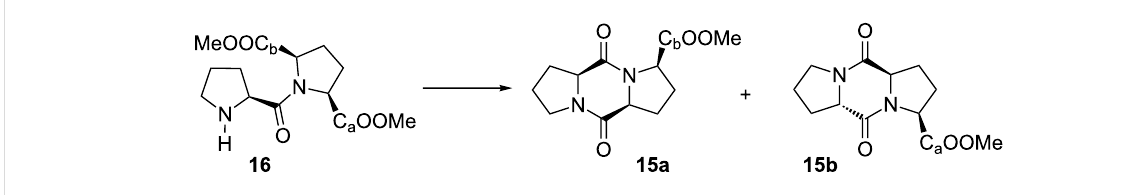
Scheme 5: Potential isomers yielded by cyclization of 16 .